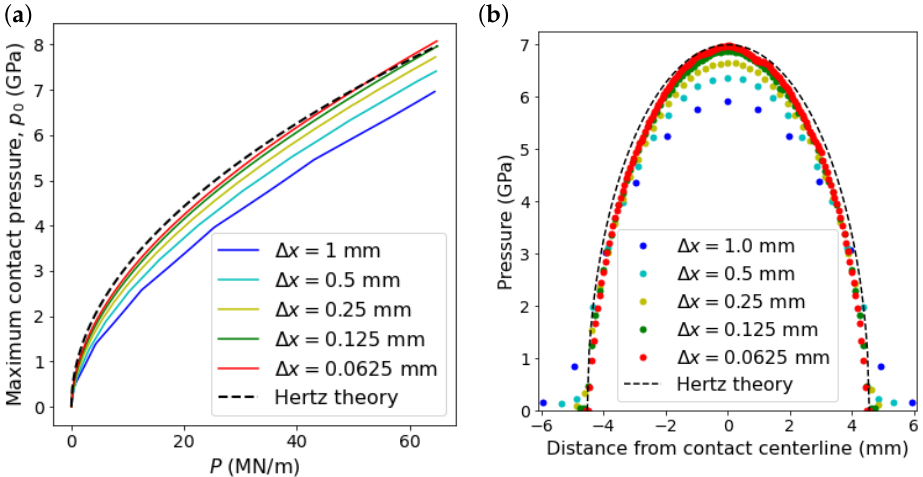
Figure 5. Comparison between the calculated contact pressure for different particle spacings and the Hertz theory; ( a ) maximum pressure at contact in terms of the applied load and ( b ) contact pressure distribution along the contact line for the applied load of